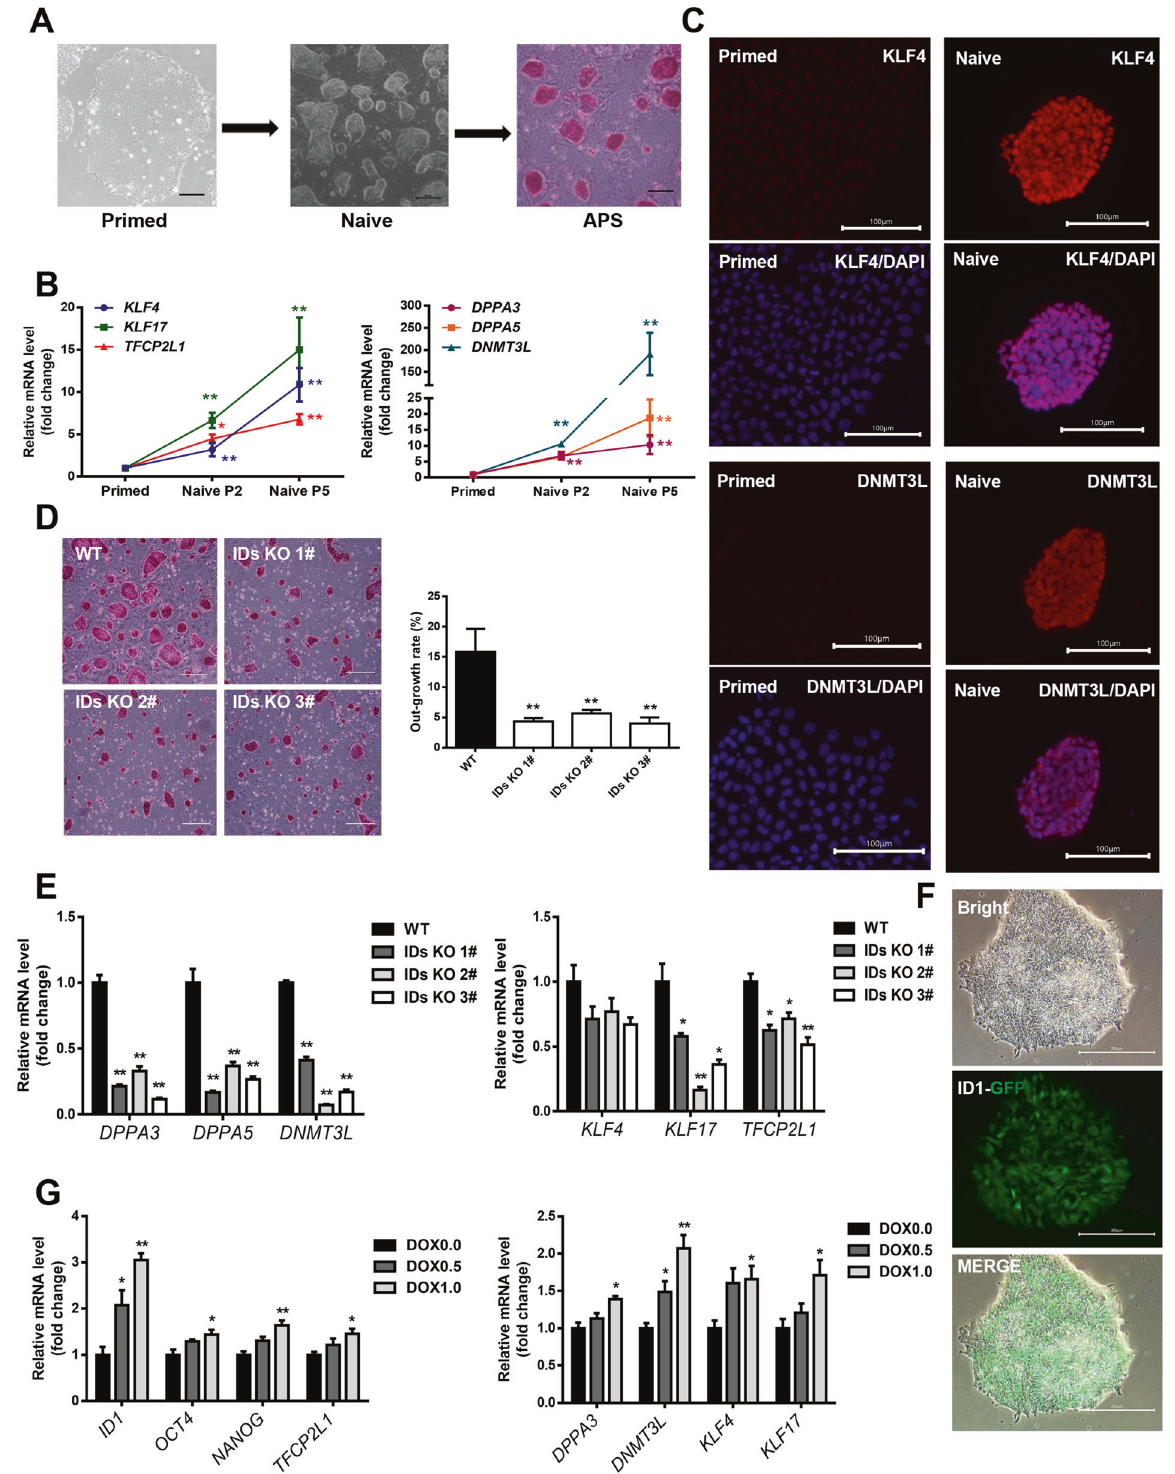
Fig. 2 ID1 and ID3 are required for the reset from primed to naive state of hESCs. A Reset primed hESCs to a naive state and alkaline phosphatase stain (APS). B Naive marker genes expression when primed hESCs reset to naive state ( n = 3), compared with primed, * p < 0.05; ** p < 0.01, data are presented as means ± SEM, one-way ANOVA followed by t -test. C Immuno fl uorescence analysis of pluripotency-related gene expression levels in naive hESC, bar = 100 μ m. D Reset WT and ID1/ID3 KO lines to naive state and the clone out-growth rate of the WT and double konckout lines ( n = 3), ** p < 0.01, data are presented as the means ± SEM, t -test. E RT-PCR detection of naive gene expression levels in the WT and KO lines ( n = 3), compared with the WT, * p < 0.05; ** p < 0.01, data are presented as means ± SEM, t -test. F Establishment of the ID1 overexpression line, and the GFP was observed when cultured in E8 with 2 μ g/ml DOX, bar = 300 μ m. G RT-PCR detection of naive gene expression levels after ID1 overexpression line were reset to naive like state and treated with different concentrations of DOX for 48 h ( n = 3), * p < 0.05; ** p < 0.01, compared with DOX 0.0 μ g/ml, data are presented as means ± SEM, one-way ANOVA followed by t -test. Cell Death and Disease (2022)